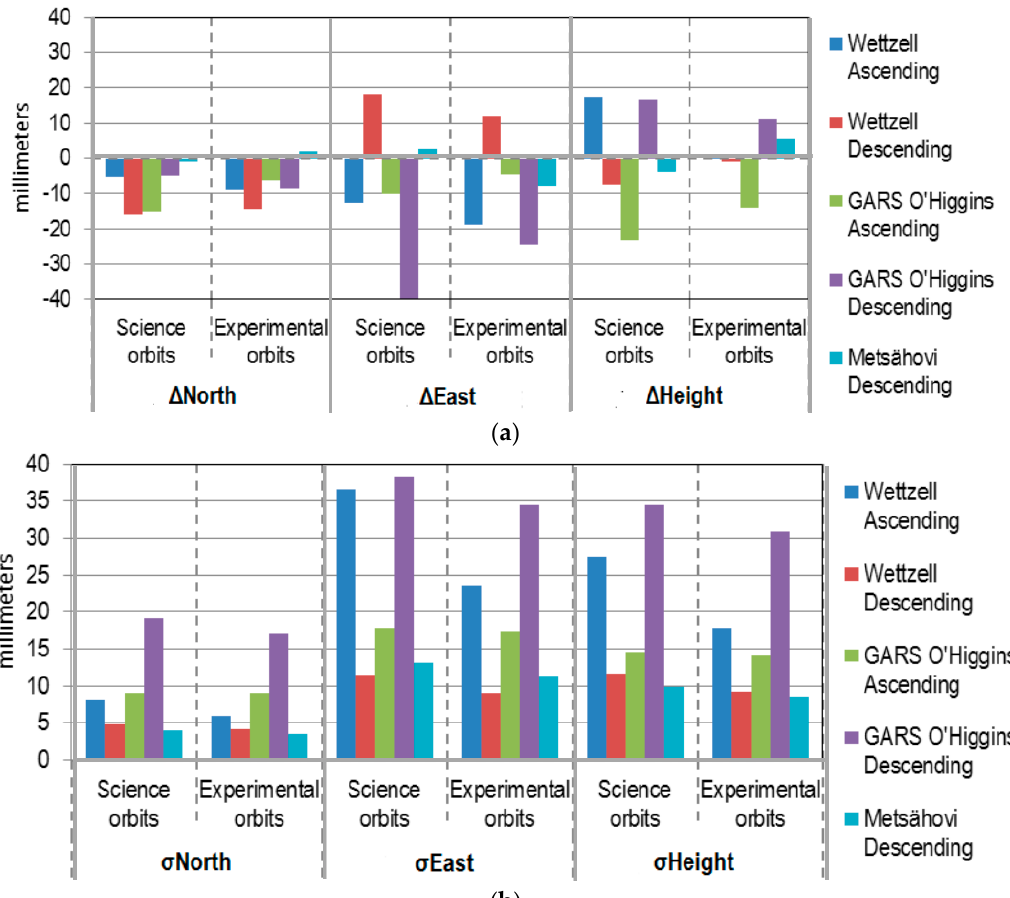
Figure 11. Comparison of the biases ( a ) and 95% confidence intervals ( b ) in north, east and height for operational Science orbits (values of Table 7) and new experimental orbits (values of Table 10). The different colors represent the different measurement series.